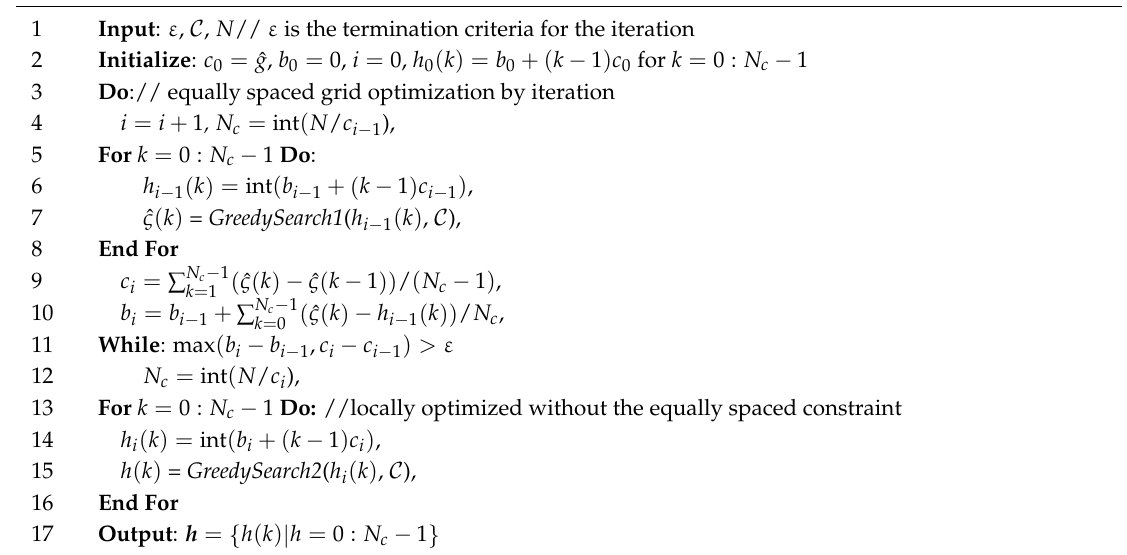
Algorithm 1. Grid Based Greedy Gait Segmentation Algorithm